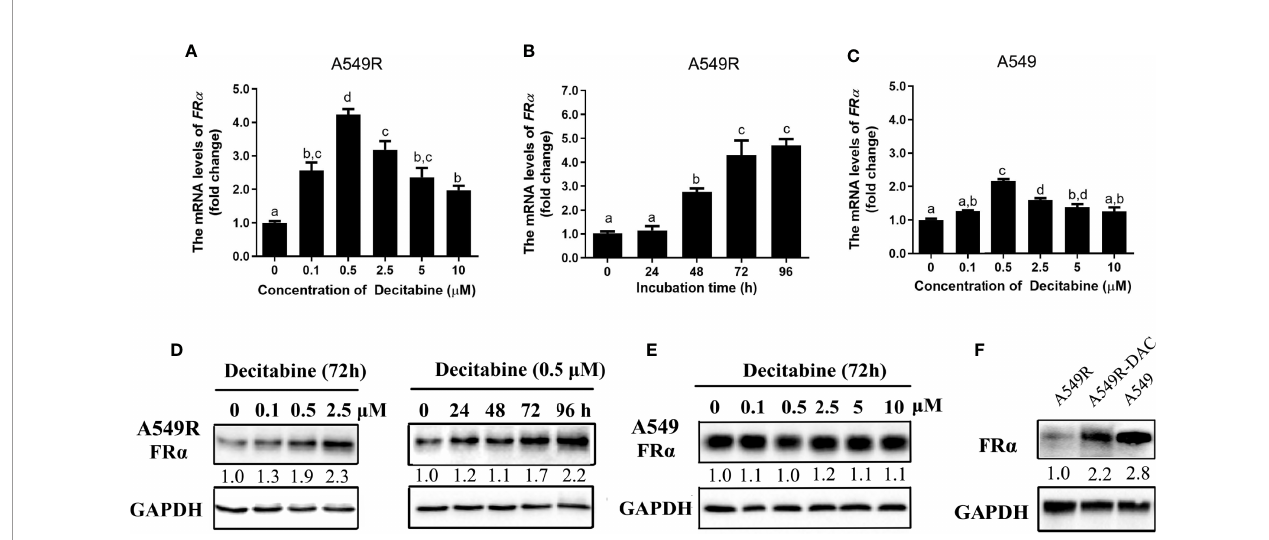
FIGURE 3 | Decitabine upregulated the expression of FR a in A549R cells in a concentration-dependent and time-dependent manner. For the concentration- dependent study, cells were treated with different concentrations of decitabine (0.1-10 m M) for 72 h before RNA or protein was extracted. For the time-dependent study, cells were treated with 0.5 m M decitabine for 24, 48, 72 or 96 h before RNA or protein was extracted. (A) Decitabine upregulated FR a expression in A549R cells in a concentration-dependent manner. (B) Decitabine upregulated FR a expression in A549R cells in a time-dependent manner. (C) Decitabine slightly upregulated FR a expression in A549 cells. (D) Decitabine increased the expression of the FR a protein in a concentration-dependent and time-dependent manner. (E) Decitabine did not alter the expression of the FR a protein in A549 cells. (F) Levels of the FR a protein in A549, A549R and decitabine-treated A549R (A549R- DAC) cells that were exposed to 0.5 m M decitabine for 72 h before proteins were harvested. Data are presented as the means ± SE, n =3. Treatment groups with different letters shower signi fi cant differences using ANOVA followed by Tukey ’ s test. For immunoblots, densitometric values are shown as optical density after GAPDH normalization using Image